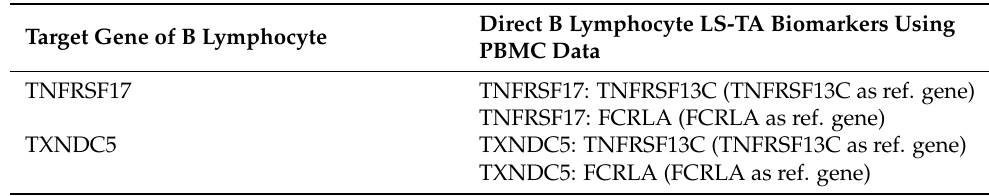
Table 4. Four Direct B lymphocyte LS-TA biomarkers used in meta-analyses.